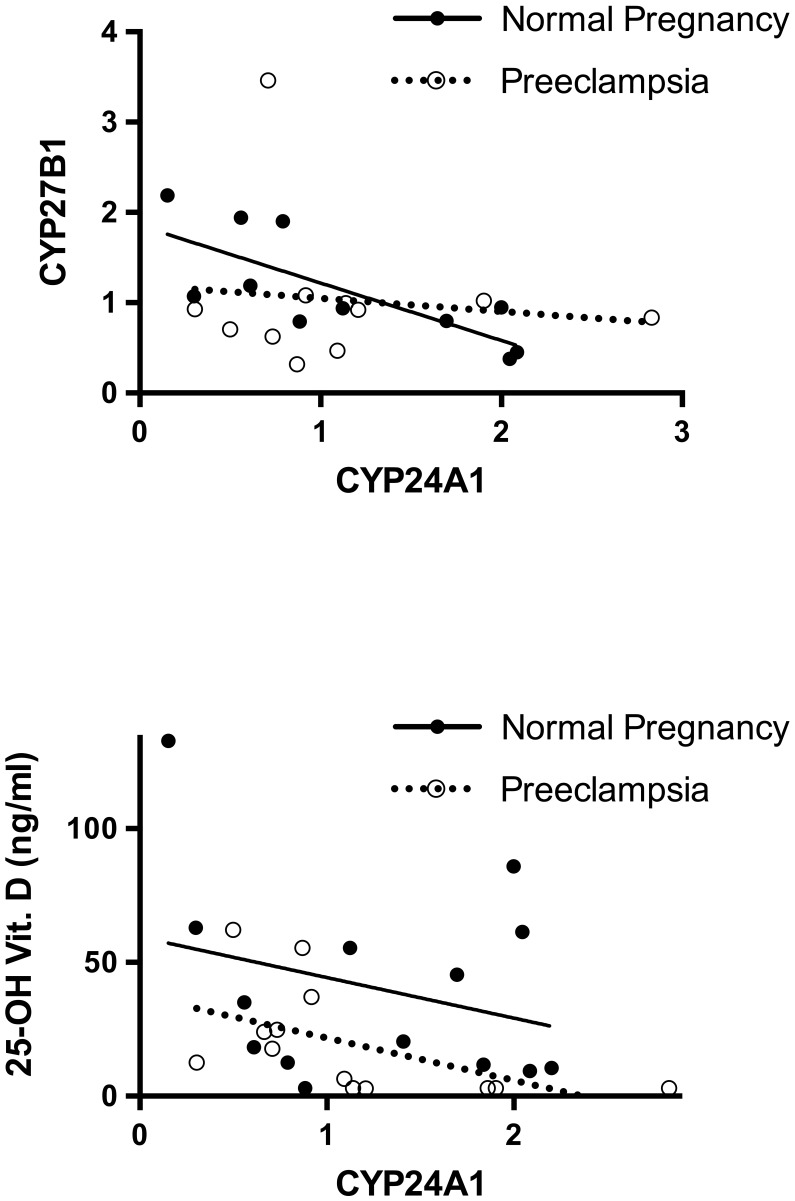
Correlation of placental mRNA expression of CYP24A1 (x-axis) and a) CYP27B1 or b) maternal 25-OH vitamin D (ng/ml) in healthy controls (black circles) and patients with preeclampsia (transparent circles).a) Placental gene expression of CYP24A1 correlates negatively with CYP27B1 expression in healthy controls (r = −0.81, P<0.0001, solid line) but not in the patients with preeclampsia (dotted line). b) CYP24A1 correlates negatively with maternal 25-OH vitamin D levels (r = −0.76, P = 0.01) in patients with preeclampsia (dotted line).